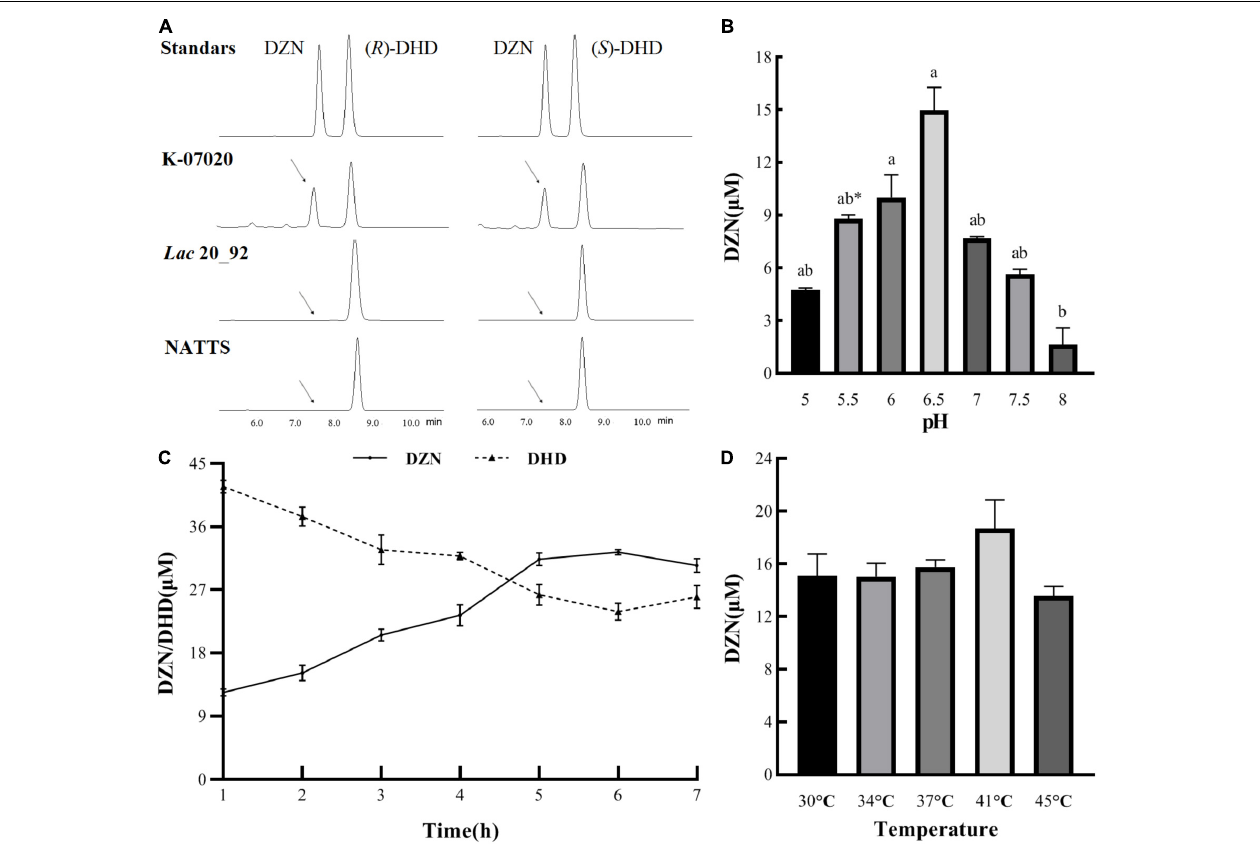
FIGURE 4 | DHD oxidase activity with K-07020. (A) Detection the DHD oxidase activity of K-07020 under aerobic conditions without NADH by using HPLC. ( R )- and ( S )-DHD were used as the substrates, it showed that both ( R )- and ( S )-DHD can be transformed to DZN by K-07020. (B) The optimal pH for oxidase activity. Different lowercase letters indicate significant differences between groups ( P < 0.05), except the groups between pH 5.5 and pH 7. ∗ Represents the group of pH 5.5 was significantly different from the pH 7 group. (C) Kinetic analysis of oxidase activity. (D) The optimal temperature for oxidase activity. Oxidase activity analysis showed that the optimal conditions for K-07020 were a pH of 6.5 and a temperature of 41 ◦ C, and kinetic parameters for this reaction are Vmax of 52.2 µ M/h and a Km of 4.2 µ